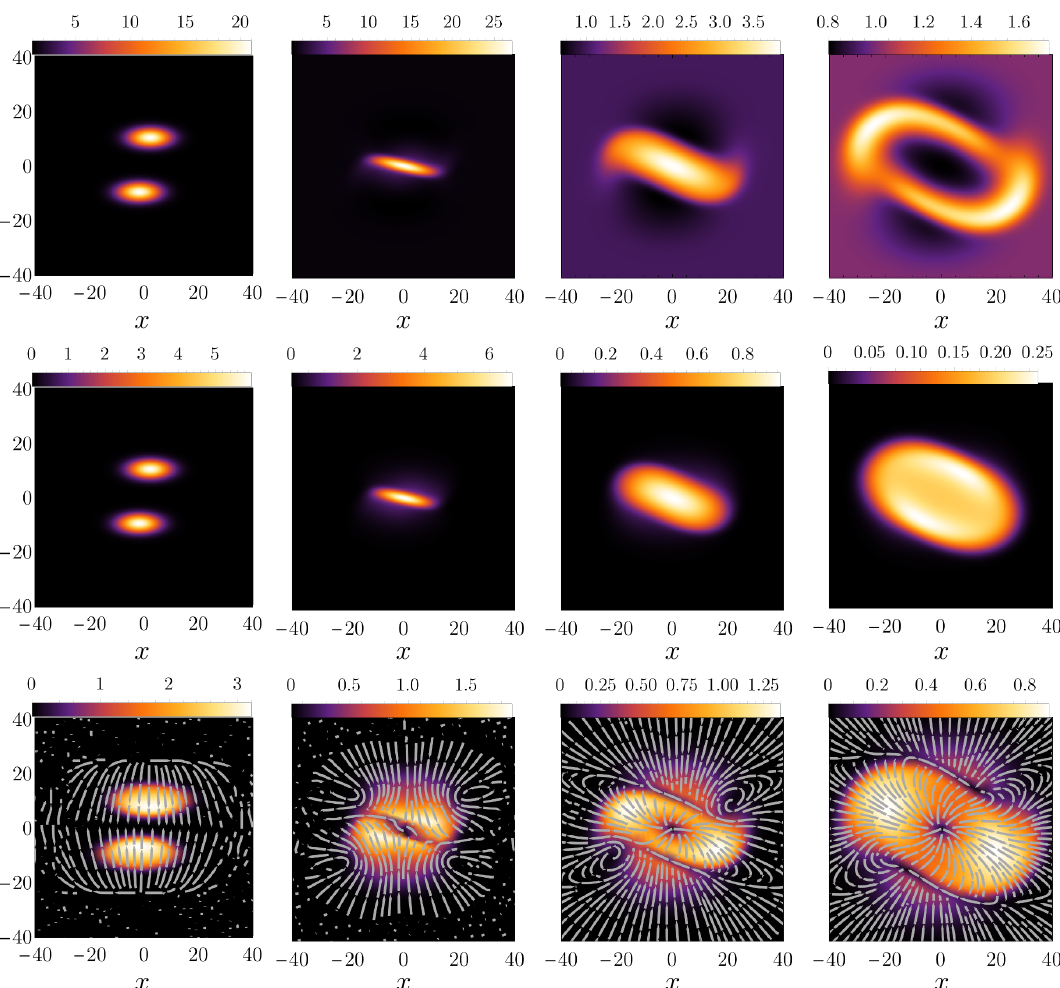
Figure 1 . Mass density (top row), charge density (middle row) and fluid velocity (bottom row) at the collision plane for a 4+1-dimensional charged oblate blob collision with δx = 2 from table 1. The snapshots correspond to t = (0 , 4 , 9 , 15) .